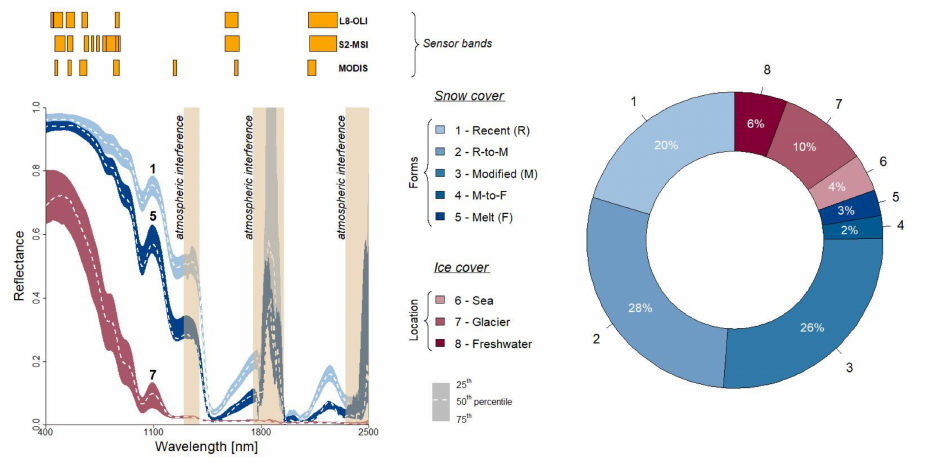
Figure 9. Aggregation of hyperspectral measurements of snow and ice cover ( left ) and statistics on the occurrence of different snow forms and ice locations ( right ). Snow cover is aggregated considering the occurrence of different snow grain